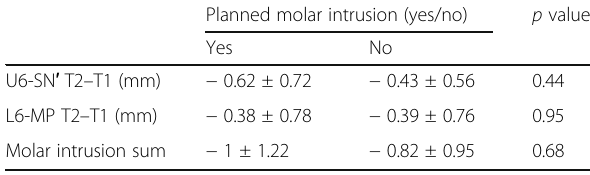
Table 4 Mean molar intrusion related to molar intrusion planned/not planned in